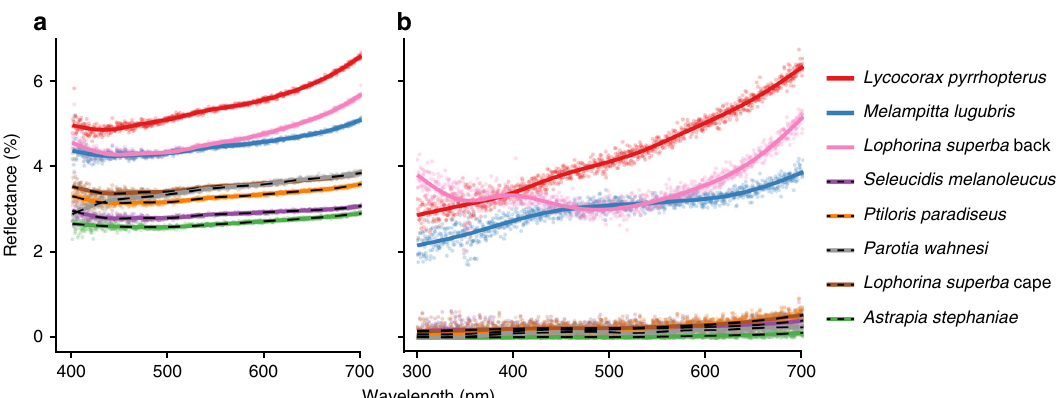
Fig. 2 Re fl ectance spectra of black and super black plumages. a Total integrated (diffuse and specular) re fl ectance. b Normal, directional re fl ectance. Dotted lines are super black plumages. See Supplementary Figs. 1 and 2 for detailed spectra for each